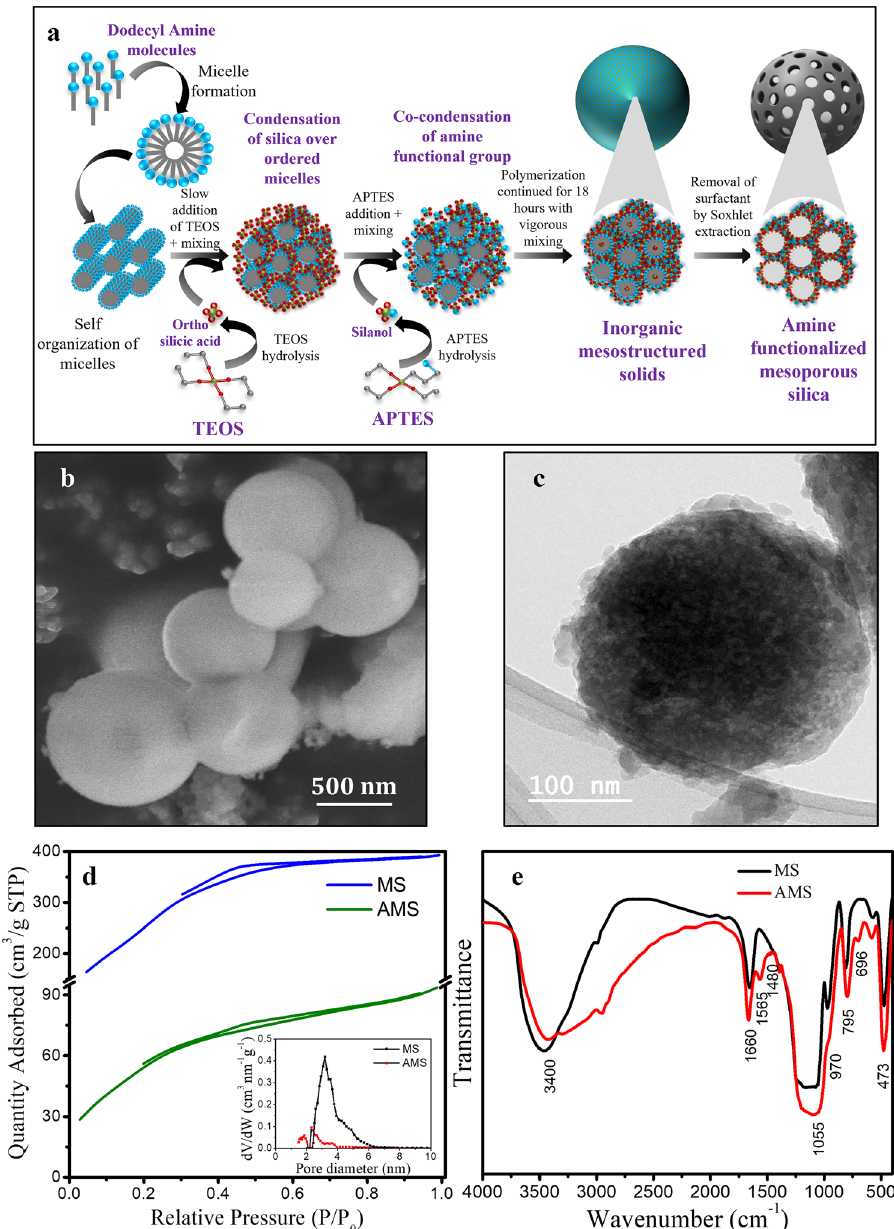
Figure 2. ( a ) Schematic of amine functionalized mesoporous silica synthesis using co-condensation technique ( b ) SEM images revealing spherical morphology ( c ) TEM images confirming porous nature. ( d ) Nitrogen adsorption–desorption isotherm of BET analysis for mesoporous silica without (MS) and with amine functionalization (AMS). Inset figure shows HK plot for pore size distribution ( e ) FTIR spectrum of MS and